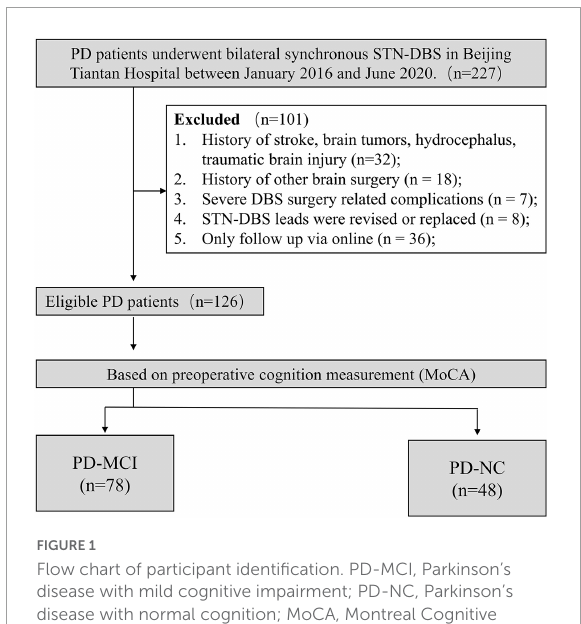
FIGURE1 Flow chart of participant identification. PD-MCI, Parkinson’s disease with mild cognitive impairment; PD-NC, Parkinson’s disease with normal cognition; MoCA, Montreal Cognitive Assessment; MMSE, Mini-Mental State Examination.